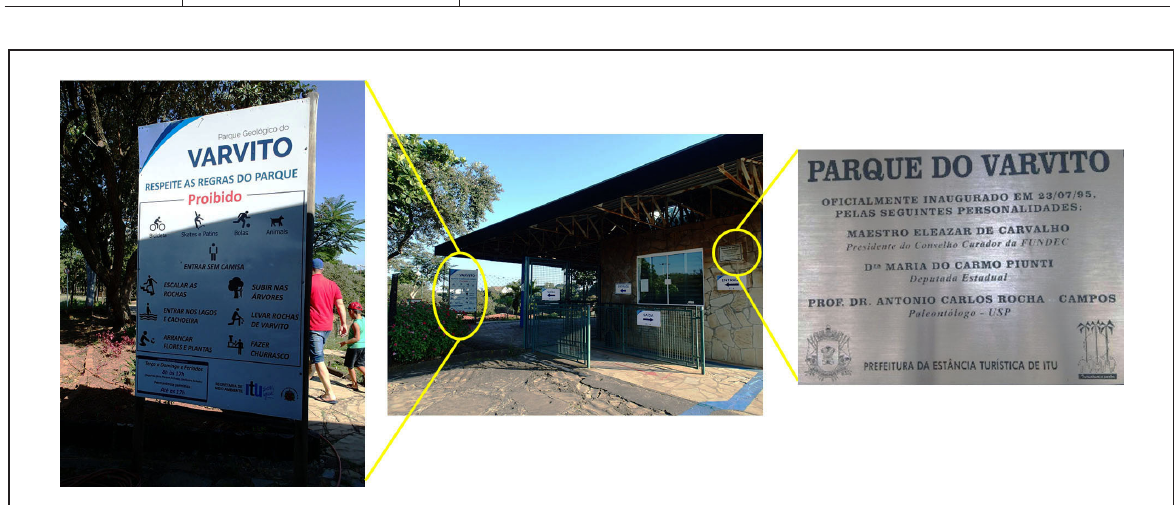
Table 2 synthetized what content stakeholders expect to